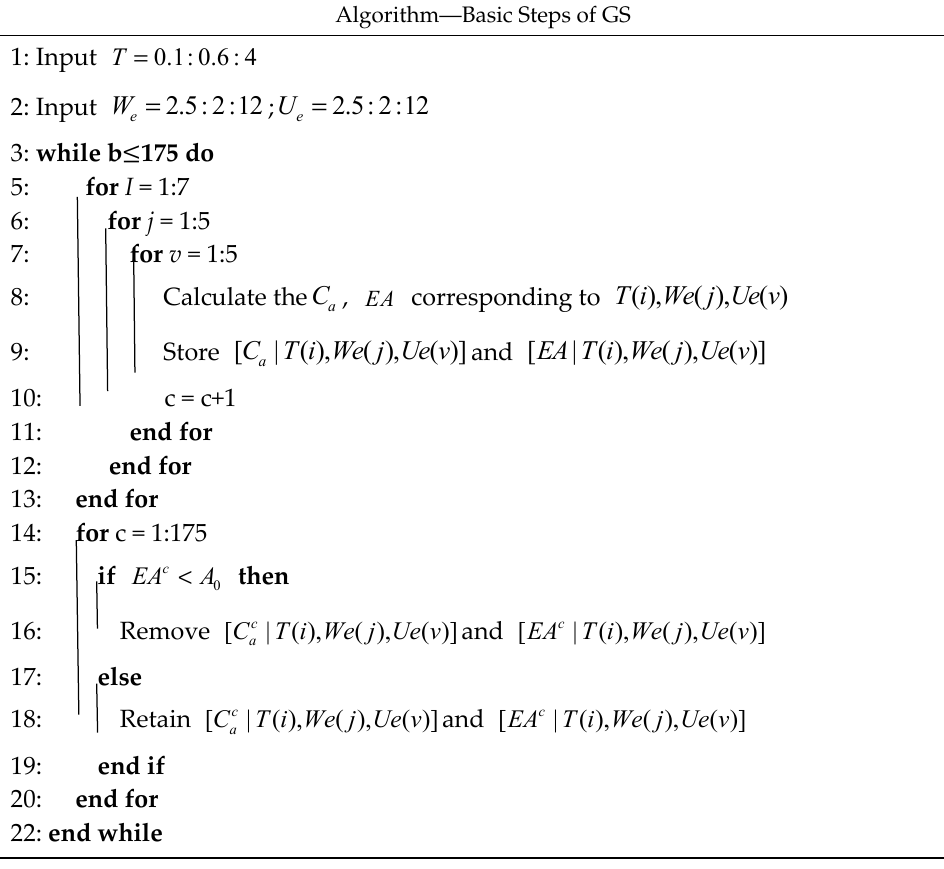
Table 2. The basic steps of the GS